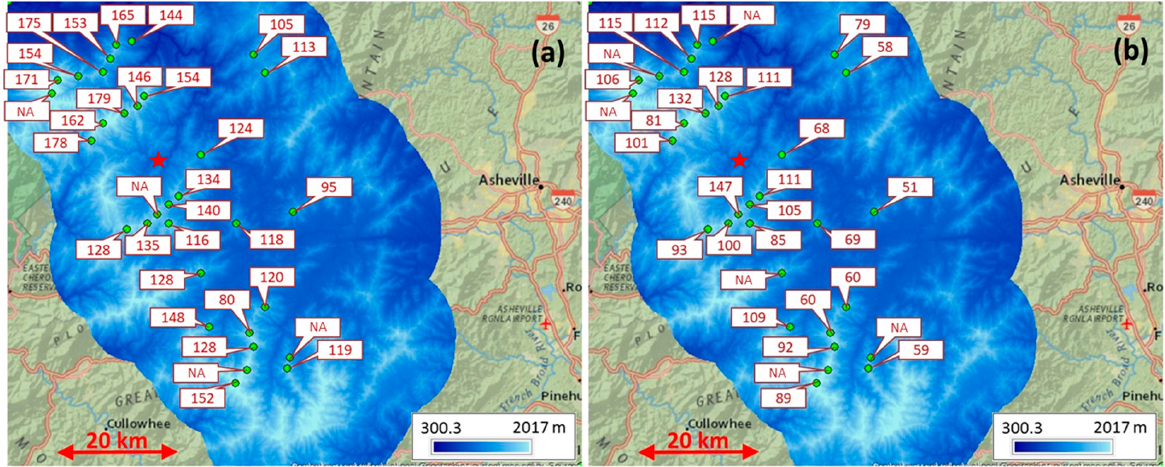
Figure 14. Rainfall accumulation (mm) observed by the Duke GSMRGN in the PRB over the period: ( a ) 5–7 February, and ( b ) 12–13 April 2020. Flag “NA” indicates rain gauge was not reported during the period. Red stars highlight the location of Cataloochee Creek in the GSMNP.